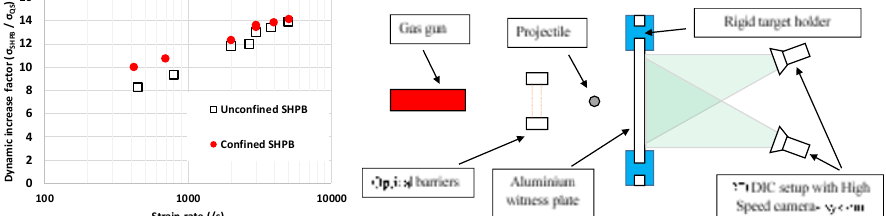
Fig. 2. Strain rate sensitivity (left) and ballistic set-up